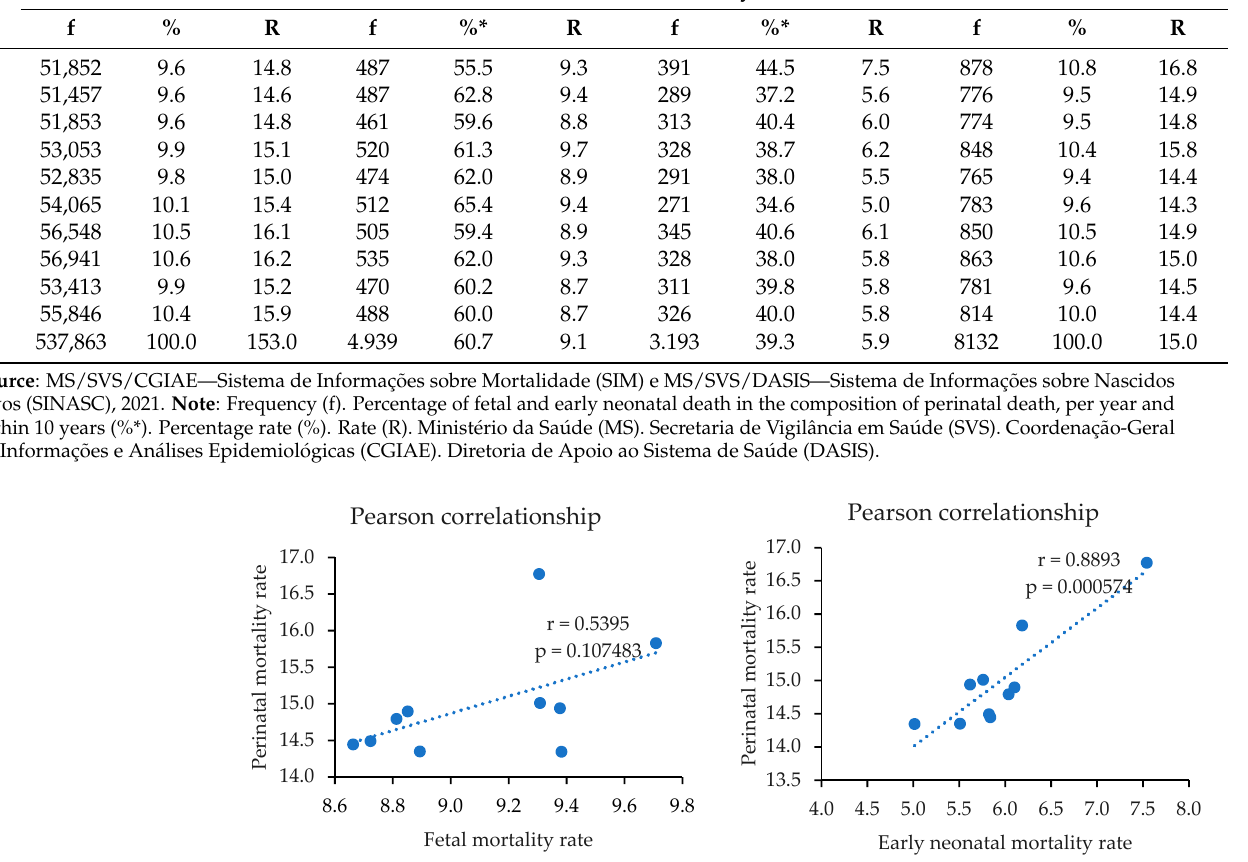
perinatal mortality rates. A positive correlation between FMR, ENMR, and PMR is as-